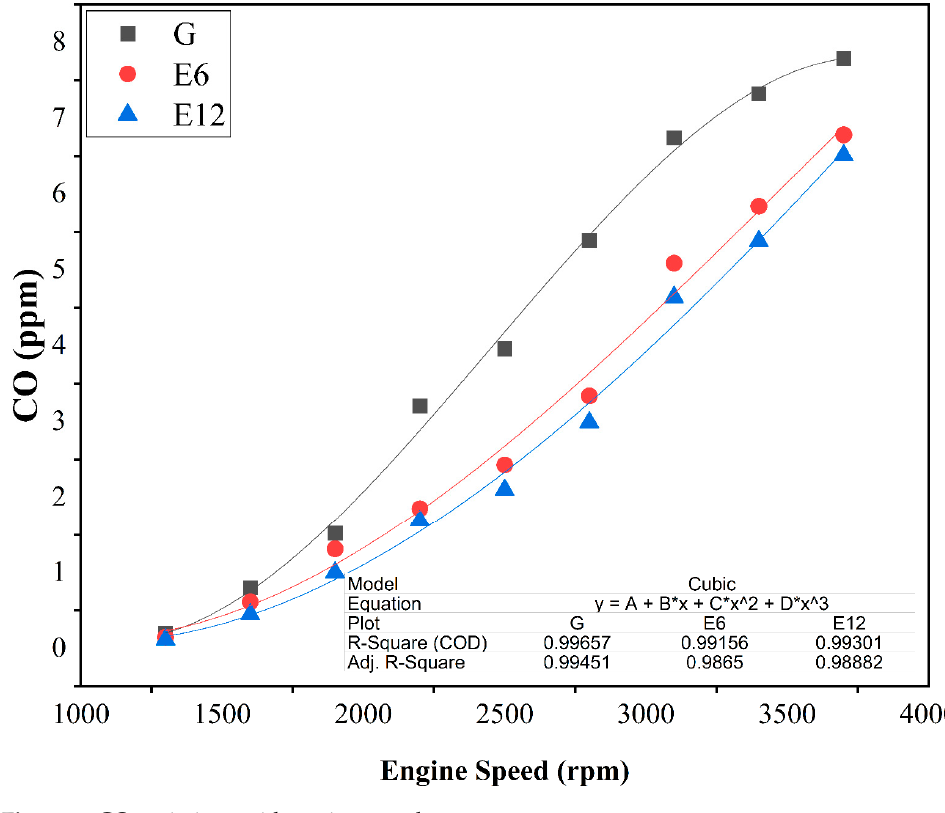
Figure 6. CO variations with engine speed.